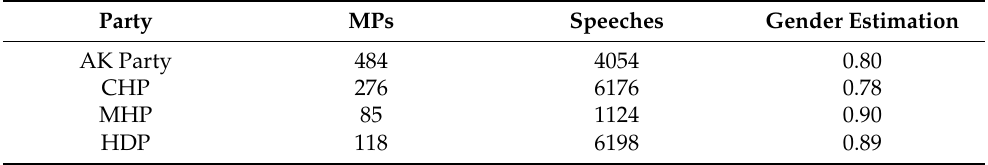
Table 7. Impact of the party affiliation on the gender